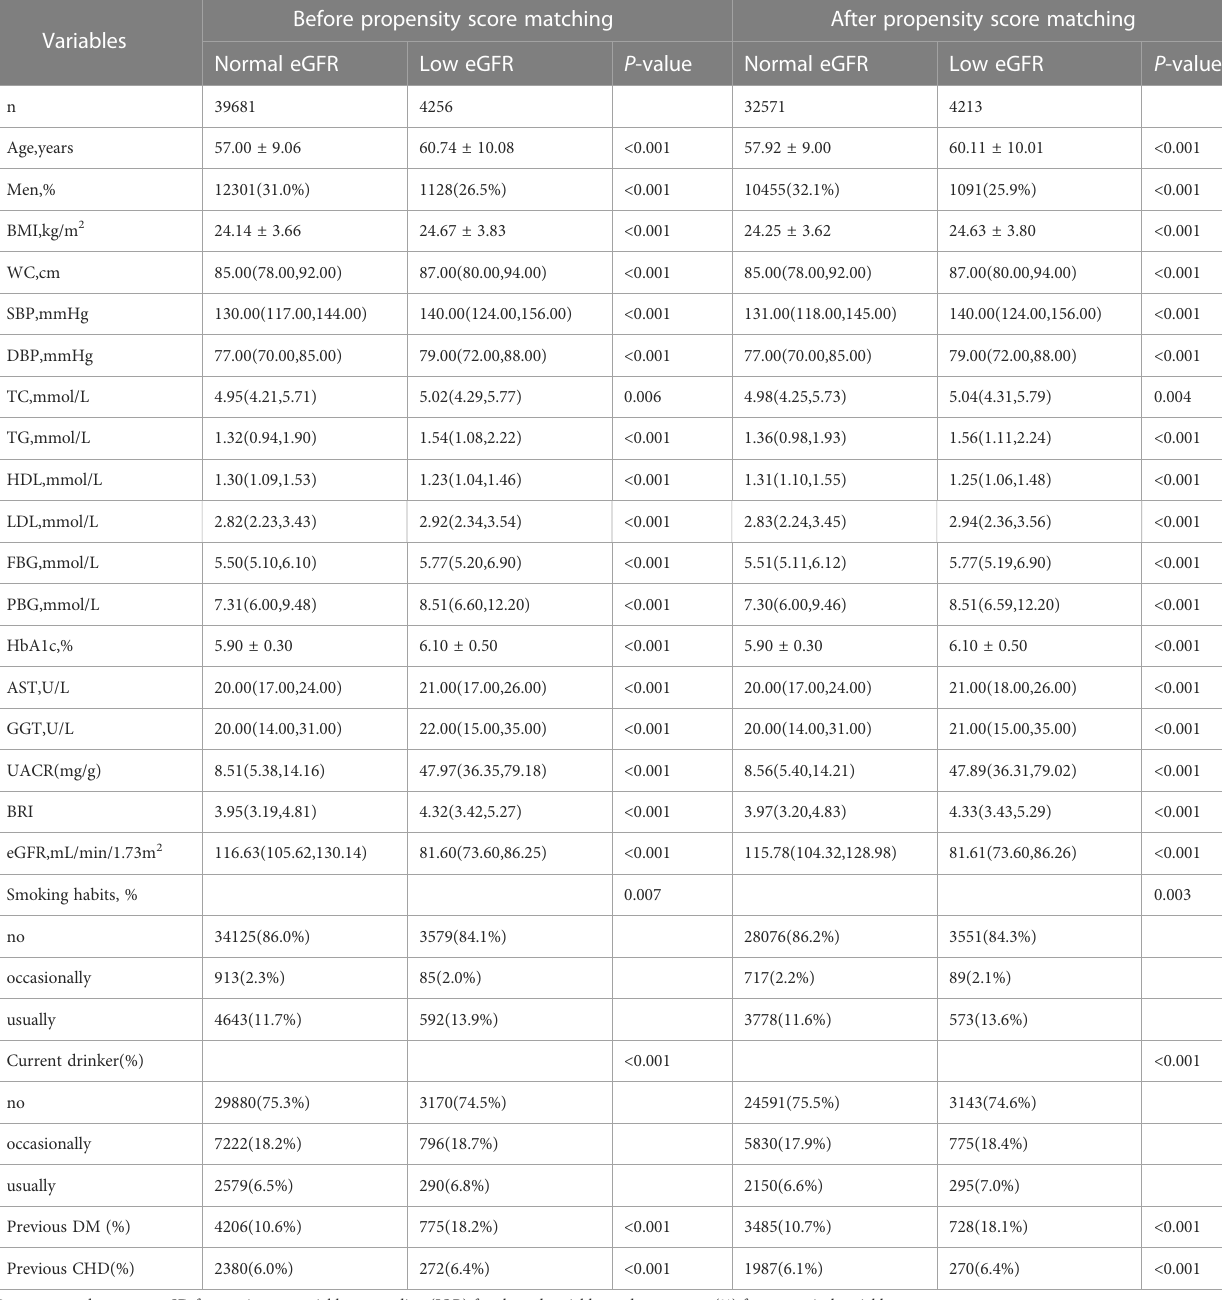
TABLE 1 Characteristics of the study population by eGFR